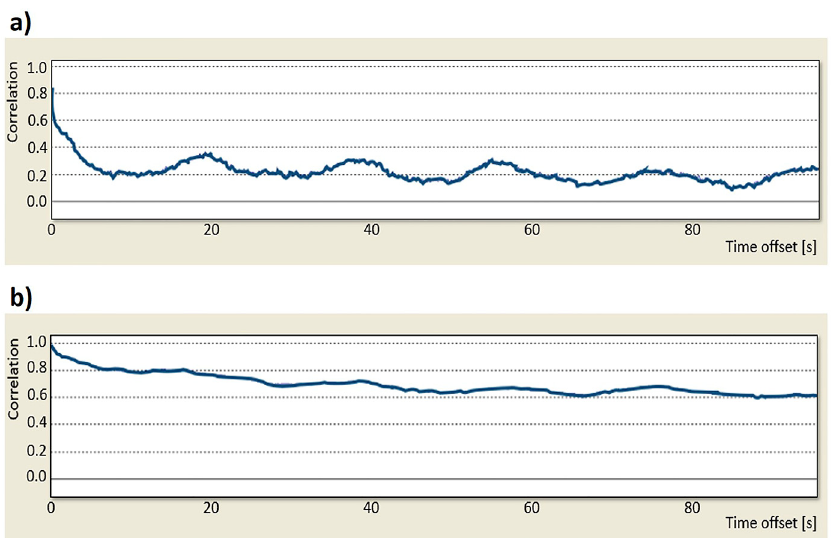
Figure 8. Autocorrelation of velocities: ( a ) at point L33, ( b ) at point L60.